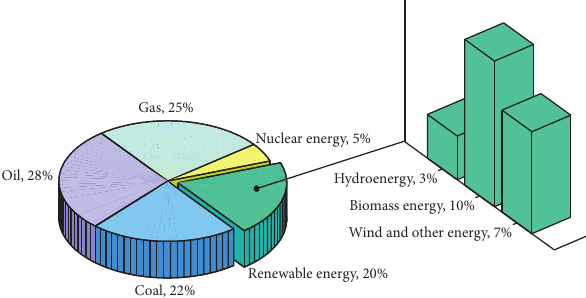
Figure 1: IEA/World Energy Outlook 2018/prediction of global energy consumption in 2040 [3].